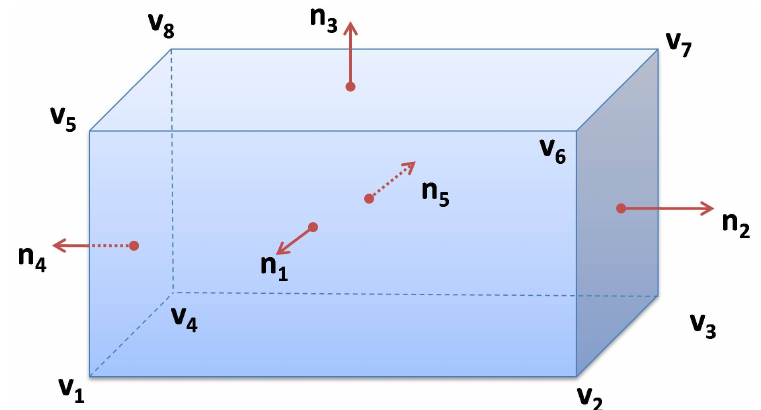
Figure 5. Extension of the proposed algorithm to search for an optimal camera placement from 2D to 3D. In the case of 3D, instead of considering the normals of the edges of the polygon, the normal vectors of the faces must be considered. Moreover, the position part of each gene ( p ) must be considered as a 3D vector. The rest of the algorithm would be the same as the 2D